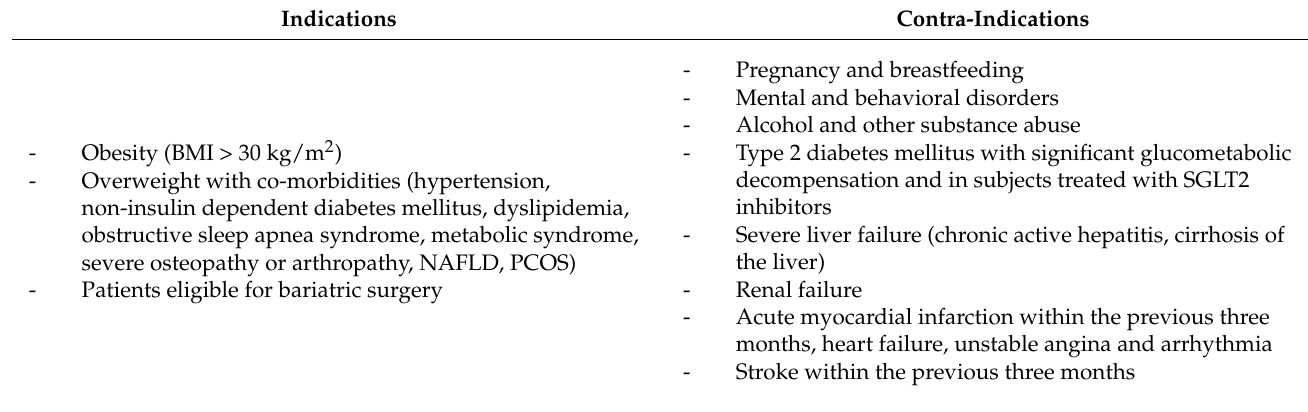
Table 3. Indications and contra-indications of ketogenic diet in